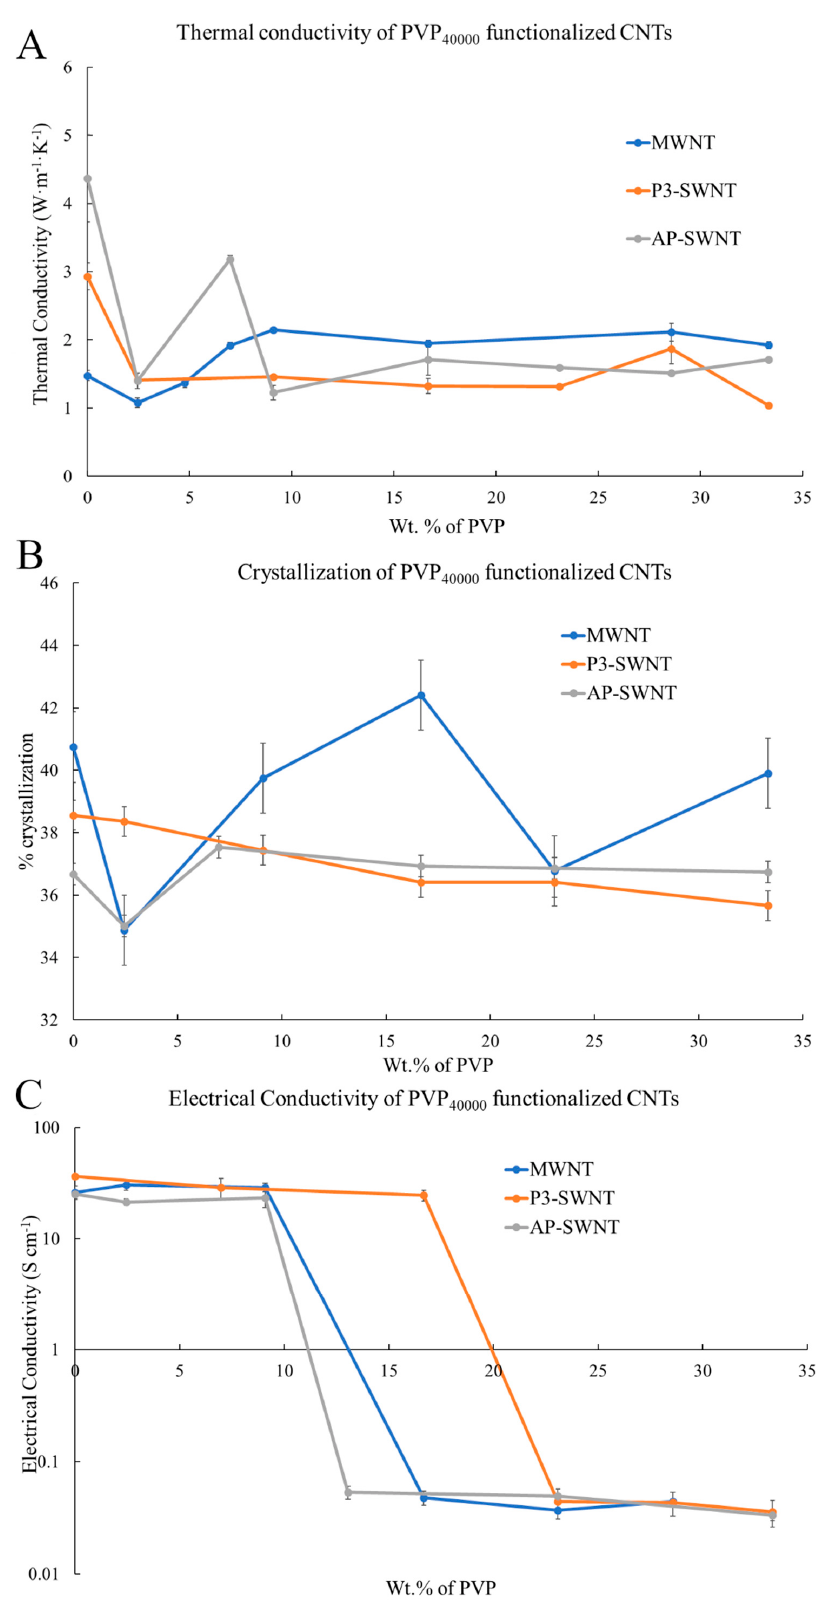
Figure 3. ( A ) Thermal conductivity of three different types of PVP 40000 functionalized CNT/PVDF composites; ( B ) Percent Crystallization; and ( C ) Electrical conductivity of PVP 40000 functionalized CNT/PVDF composites at different PVP